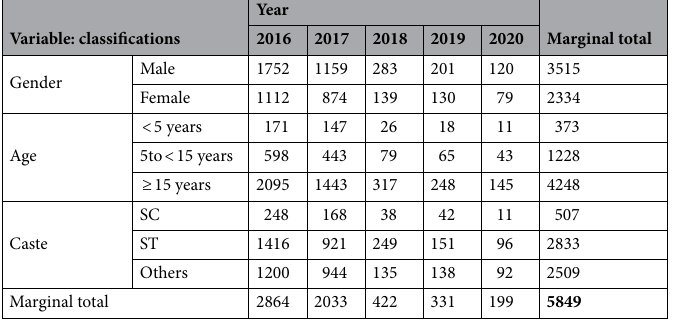
Variable: classifications